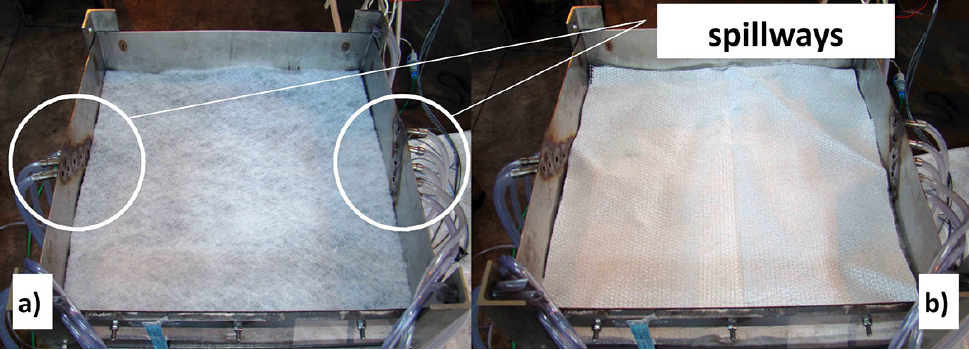
Figure 7: Spillways detail and filtering sheets: a) first layer; b) second